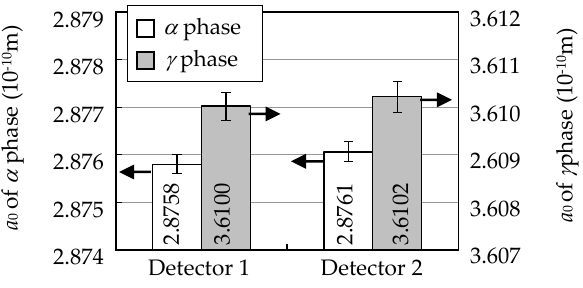
Figure 8. Neutron diffraction intensity profile of strain-free specimen [13].